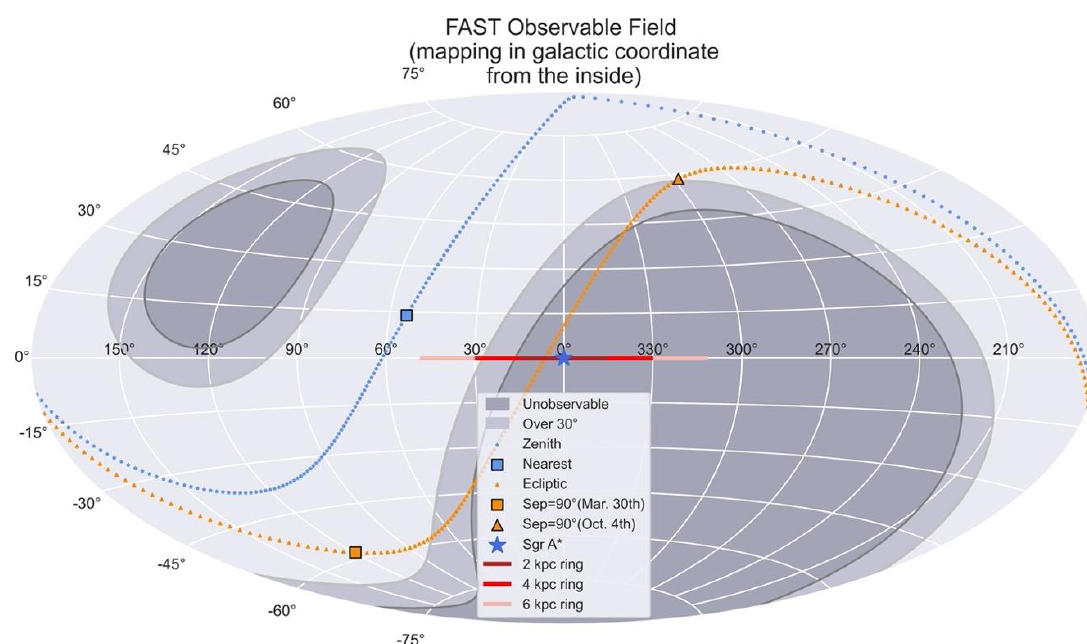
Figure 4. Observable Field of FAST.